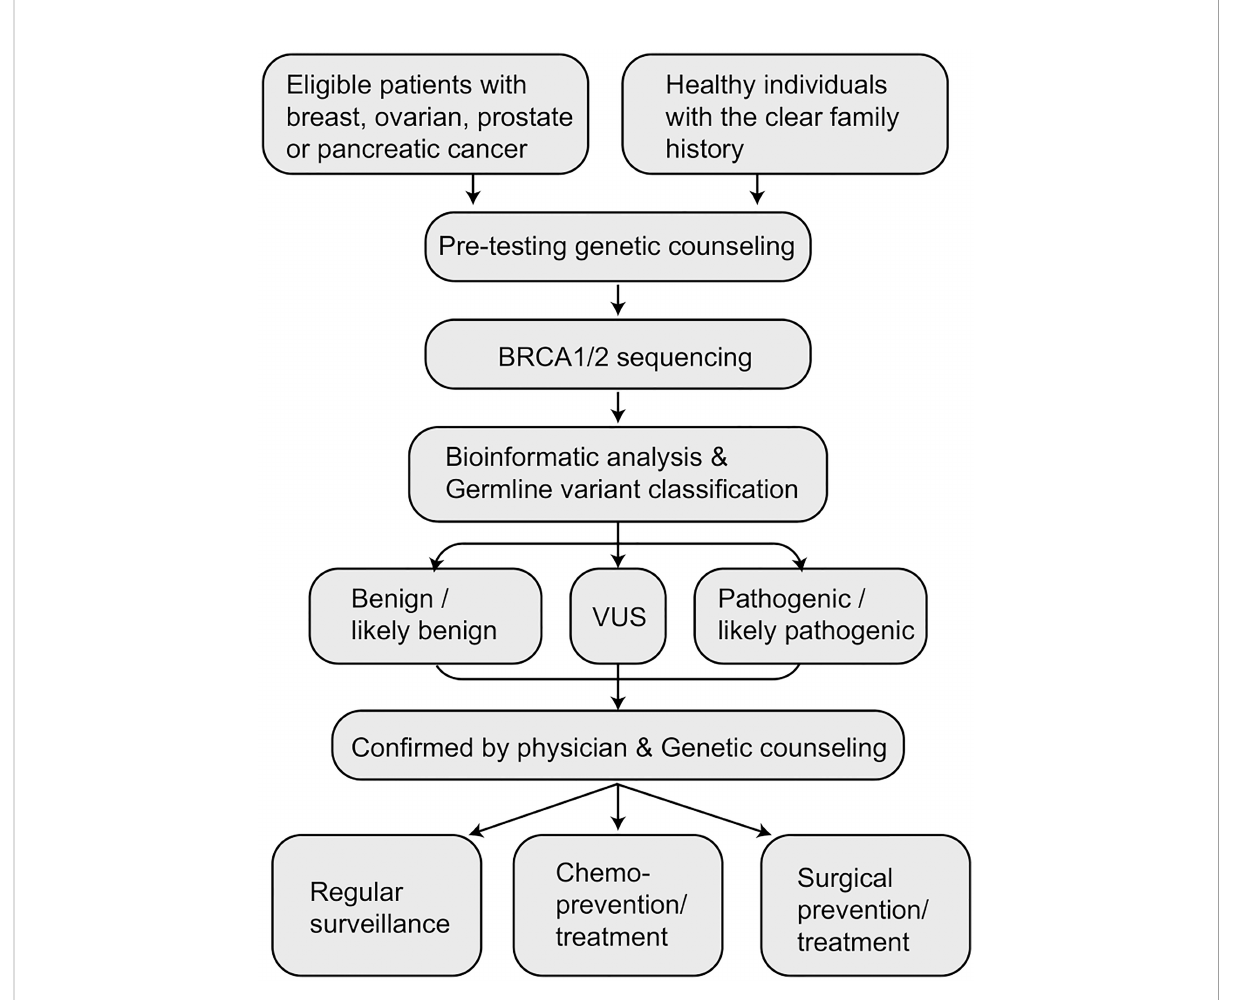
FIGURE 1 The procedure of population screening for BRCA germline mutation carriers in China (7 –